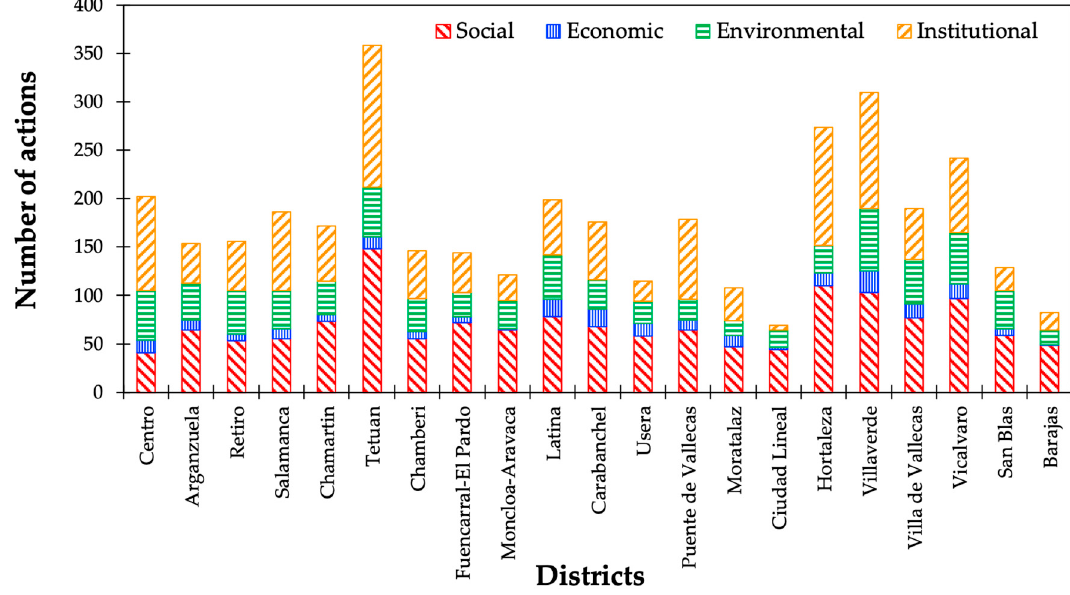
Figure 6. Categorization of actions by borough and sustainability dimension (Source: author).